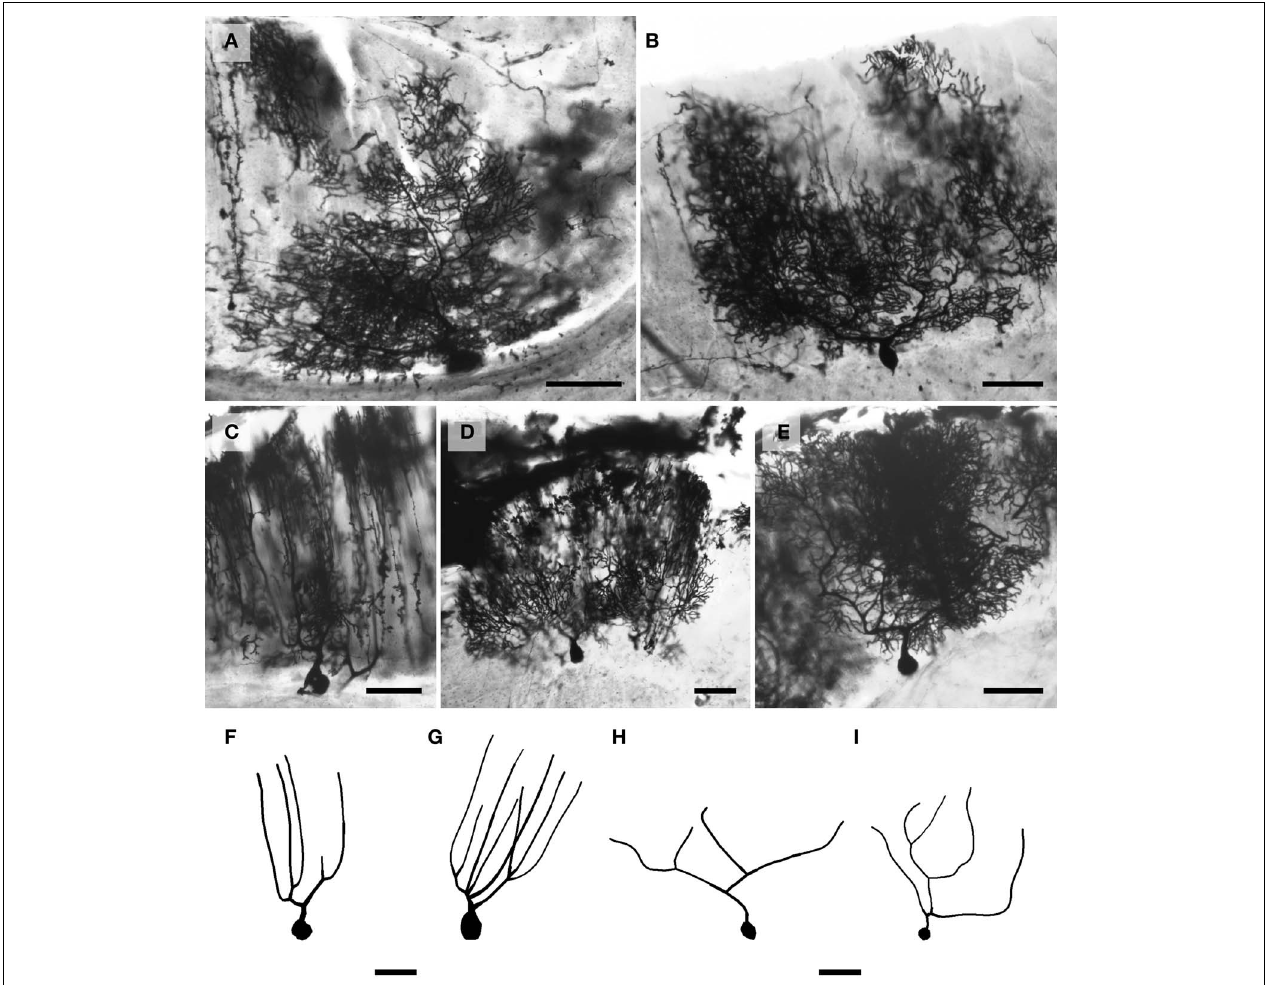
FIGURE 4 | Photomicrographs of Golgi-stained Purkinje neurons. (A) African elephant; (B) human; (C) humpback whale; (D) Florida manatee; and (E) giraffe. Note the large similarity between the neurons of all species except the humpback whale, where the Purkinje neuron appears to have